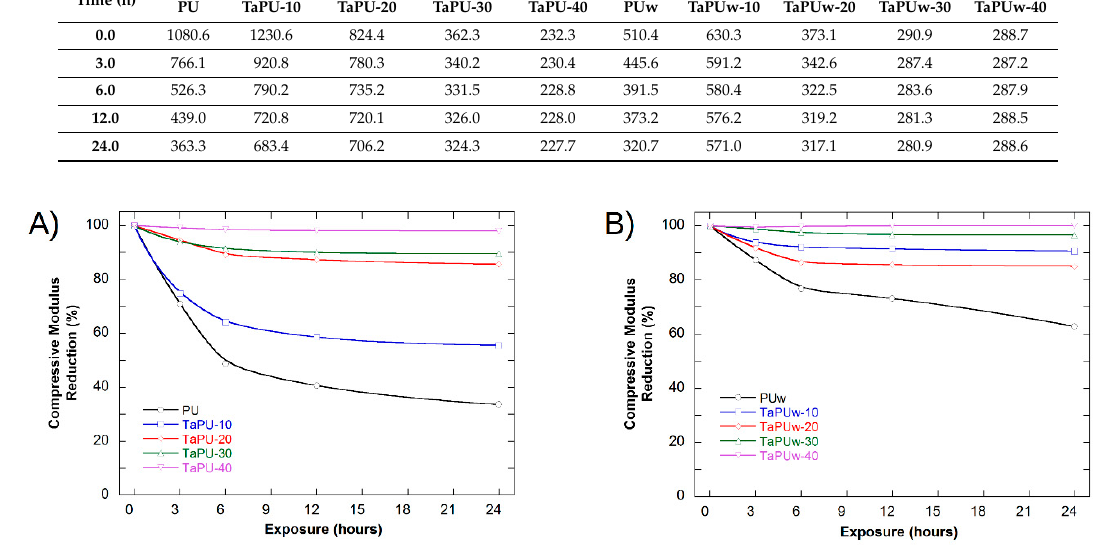
Figure 10. Percentage reduction of the compressive modulus as function of UV exposure time: ( A ) without added water; ( B ) with added water. (The solid lines are shown to guide the eyes.)